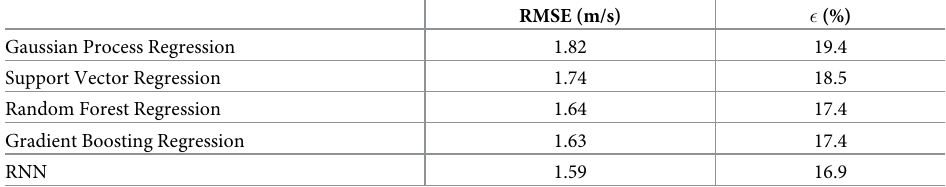
Table 2. Root mean square error (RMSE) and percentage error ( � ) on the estimated pulse wave velocity (PWV) using different machine learning methods.